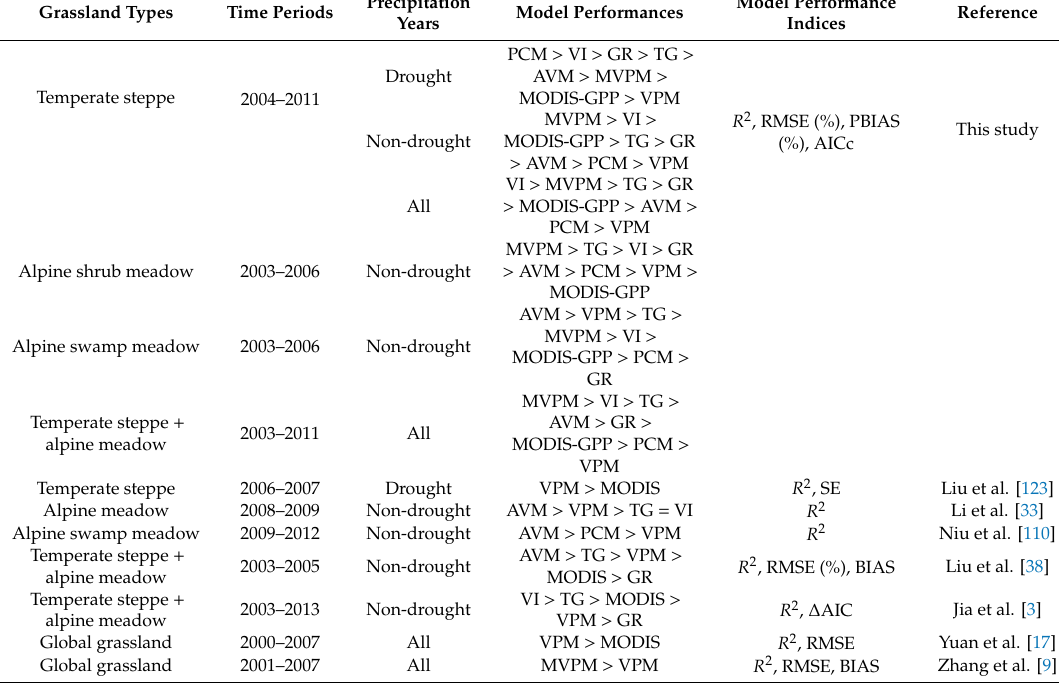
Table 5. Comparisons of the findings from this study and previous similar studies on